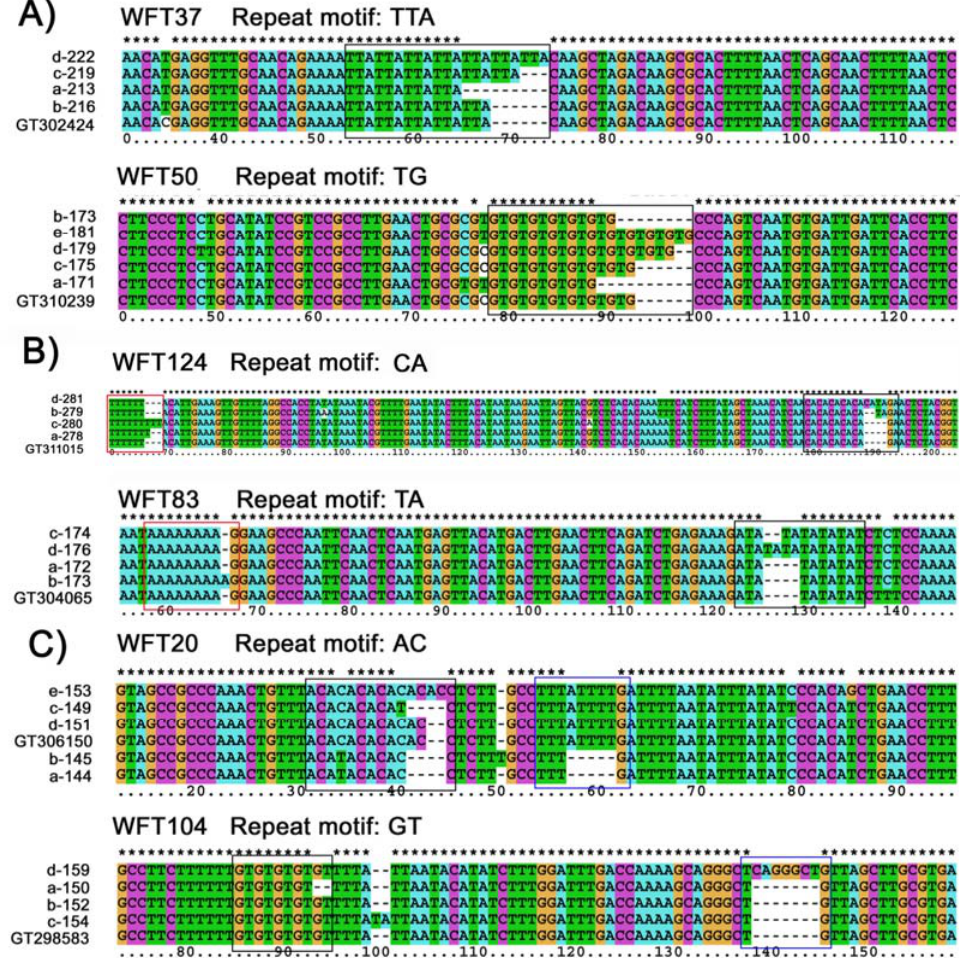
Figure 1. Mutational patterns of EST-SSRs in Frankliniella occidentalis . ( A ) microsatellites mutated in the repeat motif; ( B ) microsatellites which have one SSR in the flanking region; ( C ) microsatellites which have indels in the flanking region. Each base is indicated by a different color. The repeat motifs are shown in black box. The red box indicates the repeat motifs in the flanking region and the blue one indicates the indels in the flanking